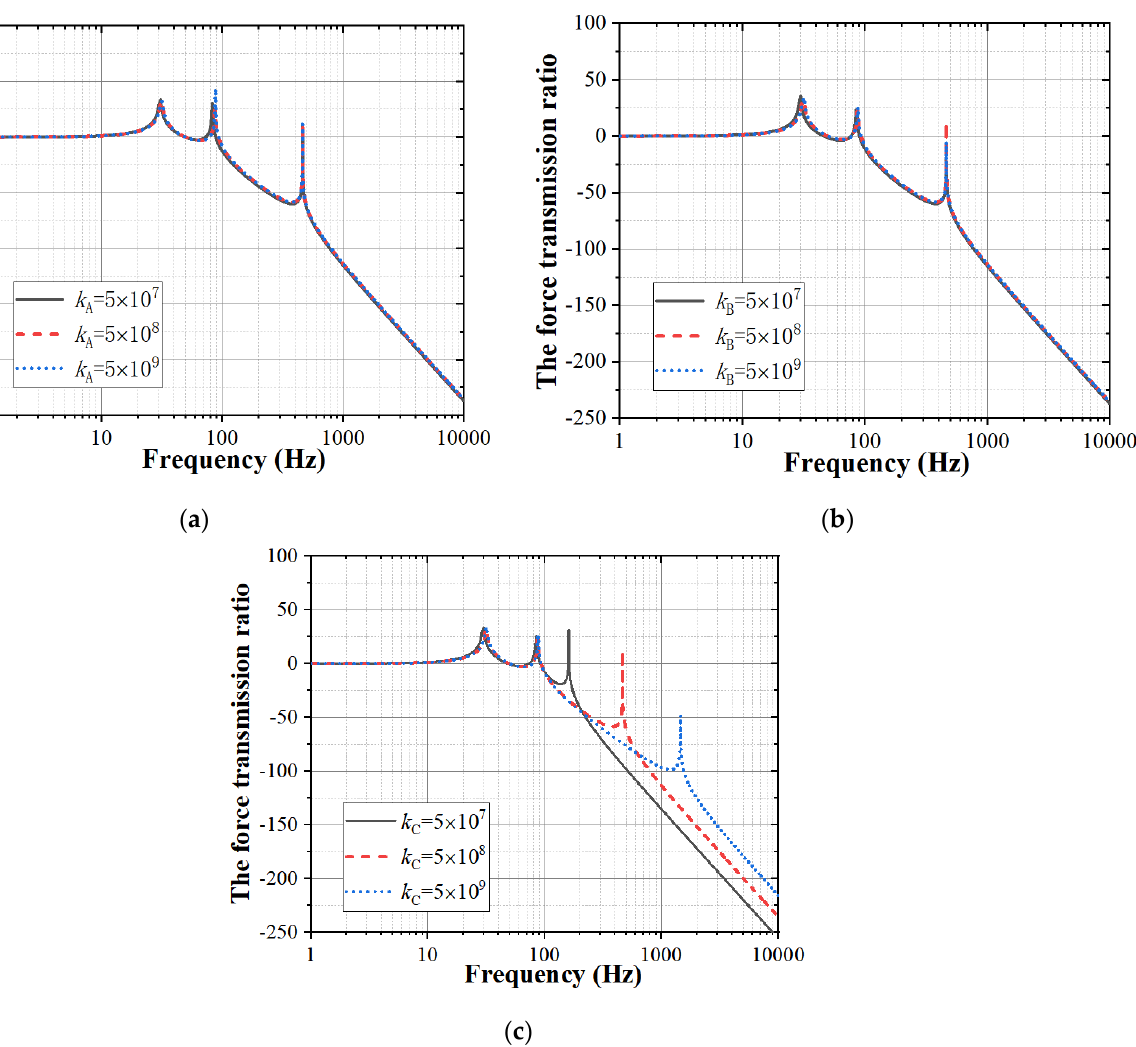
Figure 10. The force transmission ratio of the two-stage vibration isolation with ( a ) different power system stiffnesses, ( b ) different battery stiffnesses, and ( c ) different wing stiffnesses.